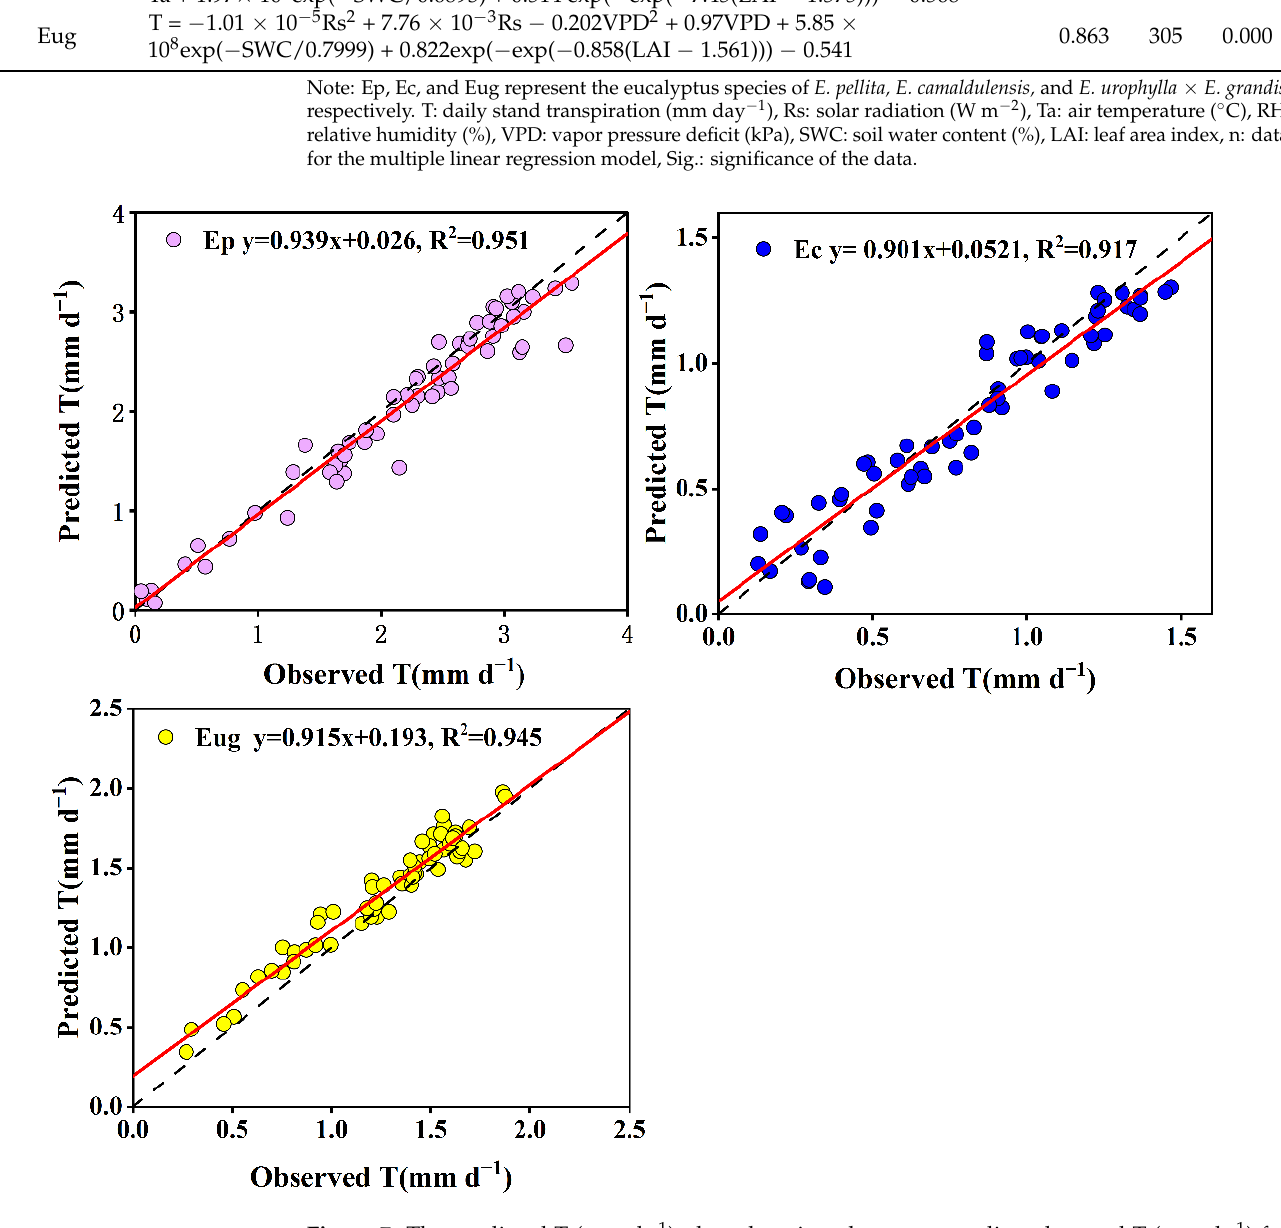
Figure 7. The predicted T (mm d −1 ) plotted against the corresponding observed T (mm d −1 ) for the three eucalyptus species. Note: The dotted line denotes the 1:1 relationship, and the solid line indicates the actual relationship between the predicted and observed values. Ep, Ec, and Eug represent the eucalyptus species of E. pellita, E. camaldulensis, and E. urophylla × E. grandis , respectively.